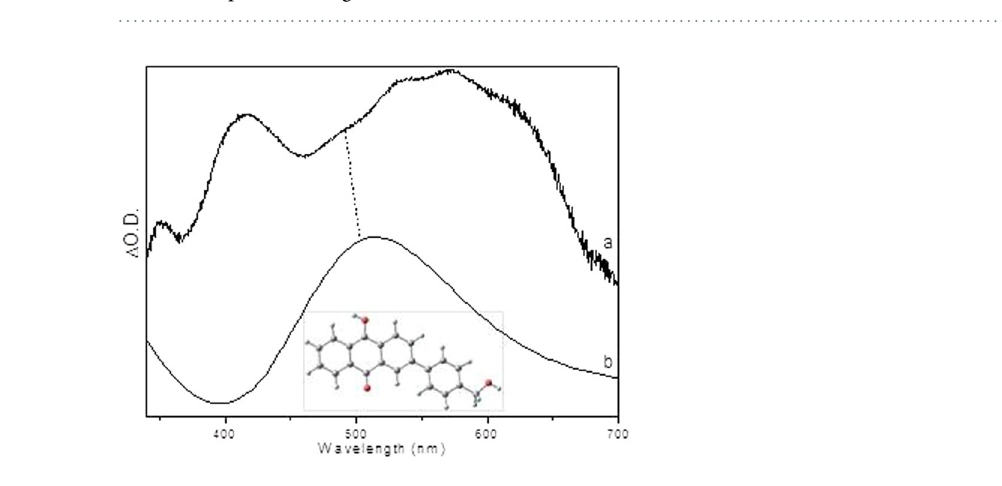
Figure 12. Comparison of ( a ) the experimental ns-TA spectrum of PPAQ obtained at 61.87 ps time delay of in pH 2 MeCN-H 2 O (1:1) recorded with 266 nm excitation to ( b ) the calculated UV-vis spectrum of the species 5 at para -postion using um062x/6-311 G **